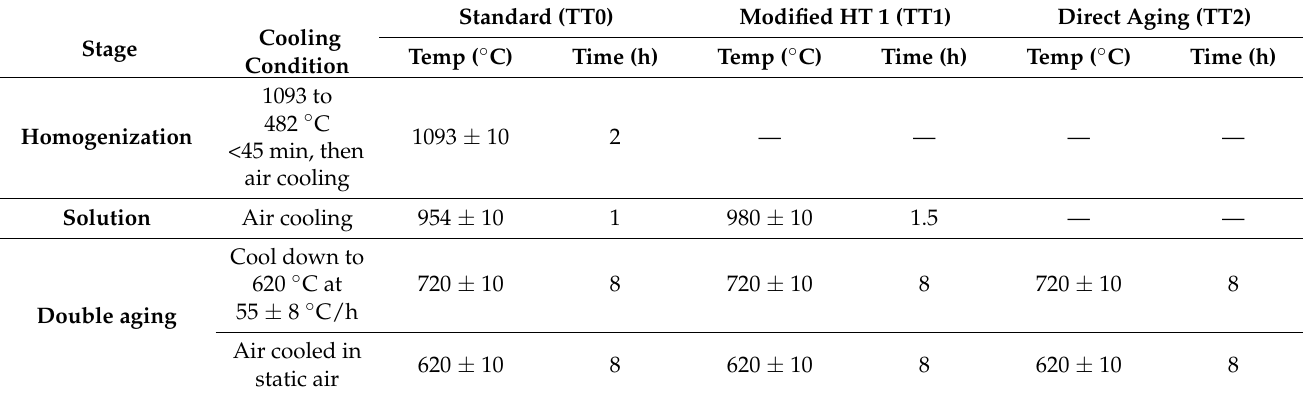
Table 3. Conditions for solid homogenization, solution, and artificial aging heat